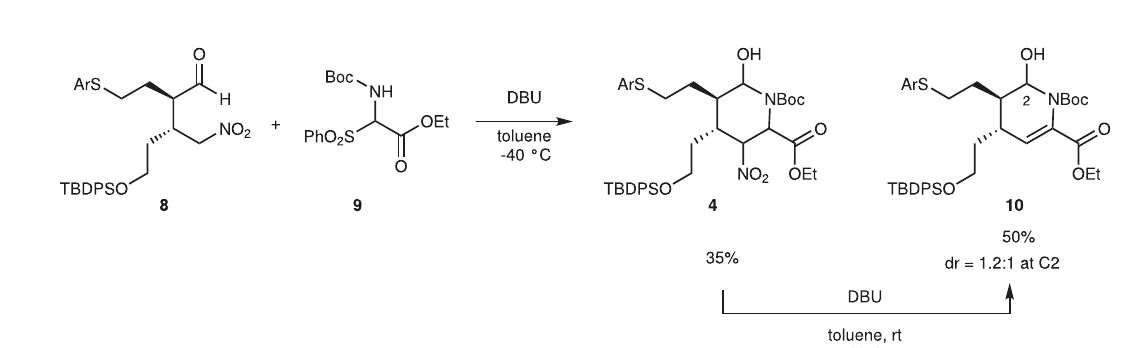
pot 2: Five reactions in one-pot sequence, 78% (8.1 g)